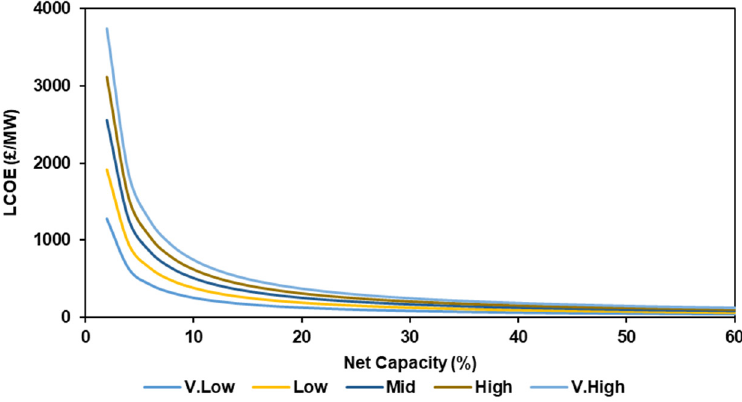
Figure 5. Net Capacity Factor vs. LCOE. Table 13. LCOE Sensitivity.